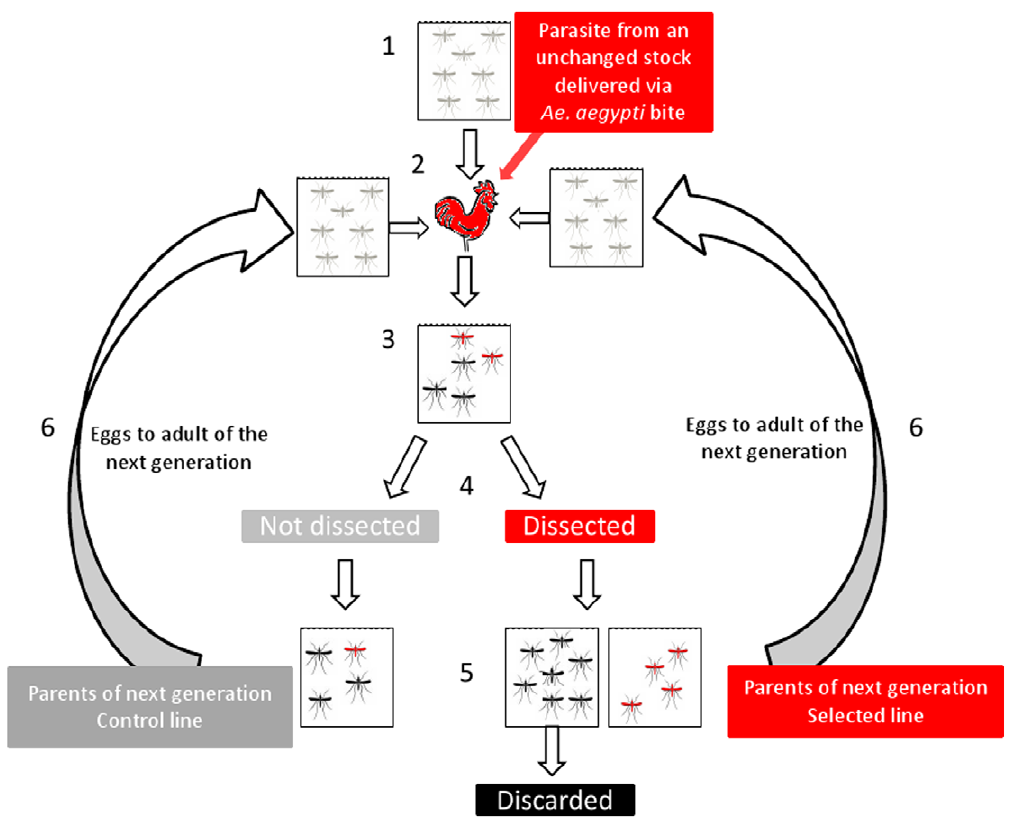
Figure 1. Selection protocol for increasing vector susceptibility. Schematic illustrating selection protocol for increased vector susceptibility (nVC) in An. stephensi infected with P. gallinaceum . (1) An. stephensi colony mosquitoes randomly chosen for the selection experiment; (2) feed on P. gallinaceum infected chicken (side by side with Ae. aegypti , used as positive control); (3) Mosquitoes separated out individually on day 5 p.i for oviposition. On day 6 p.i., a subset of the females that laid eggs (50 , N , 200) were dissected for determination of oocyst count in their midgut i.,e., red denotes infected and black denotes uninfected. (4) Eggs set up from all infected mosquitoes (red) to generate the next generation of the selected line and from a matching number of unknown (not dissected) females to generate the next generation of the control line (gray). (5) Larvae reared to adults for next cycle. (6) Offspring of the selected and control line fed again on an infected chicken. Processes 2–6 repeated for subsequent